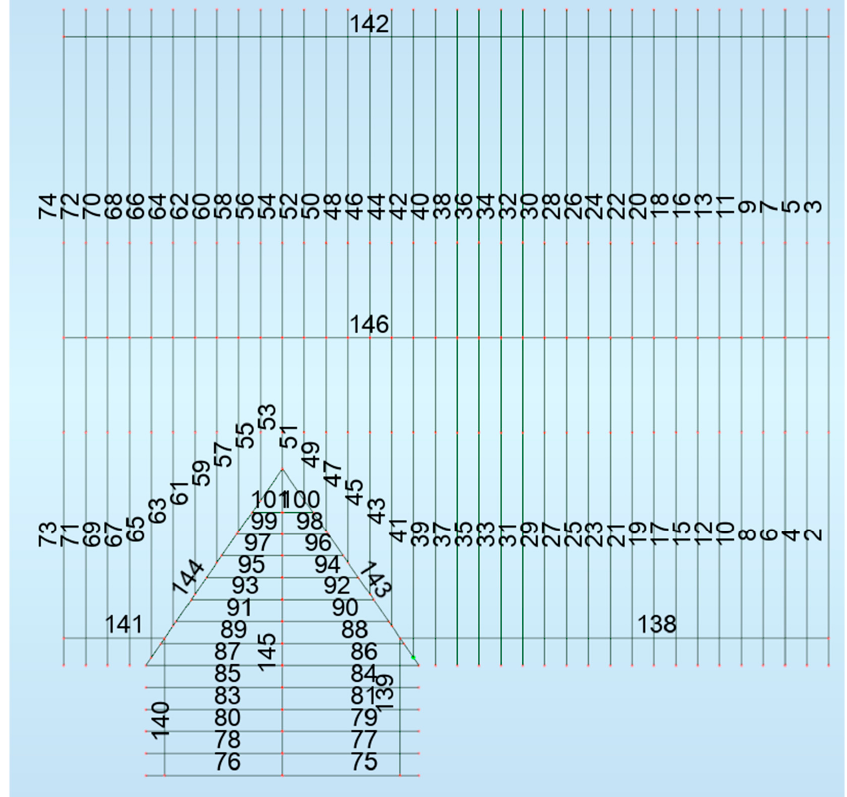
Figure 8. Roof truss construction. Numbering of roof bar elements.